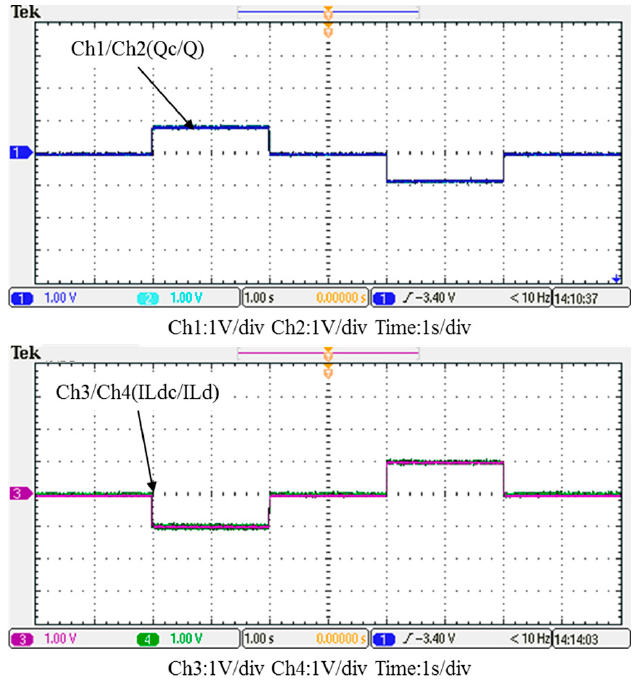
Figure 32. Case 2 implementation result: feedbacks and commands of reactive power and inductor current (all control signals are in V).